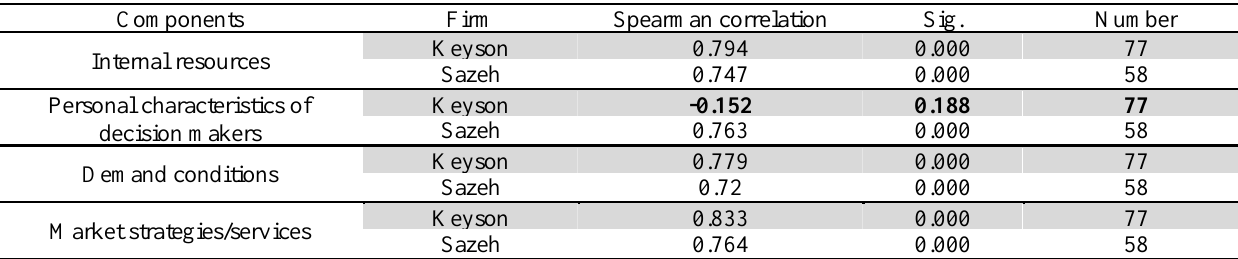
The results of Spearman